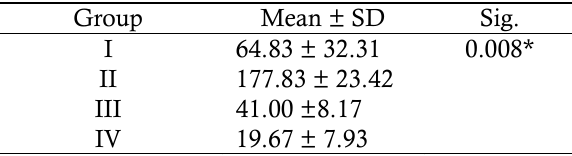
(*) Kruskal Wallis results shows a difference among groups at 5% significance level Table 2. The mean of cell damage number ( D ) in liver of rats exposed to formaldehyde of different groups Group mean ± SD